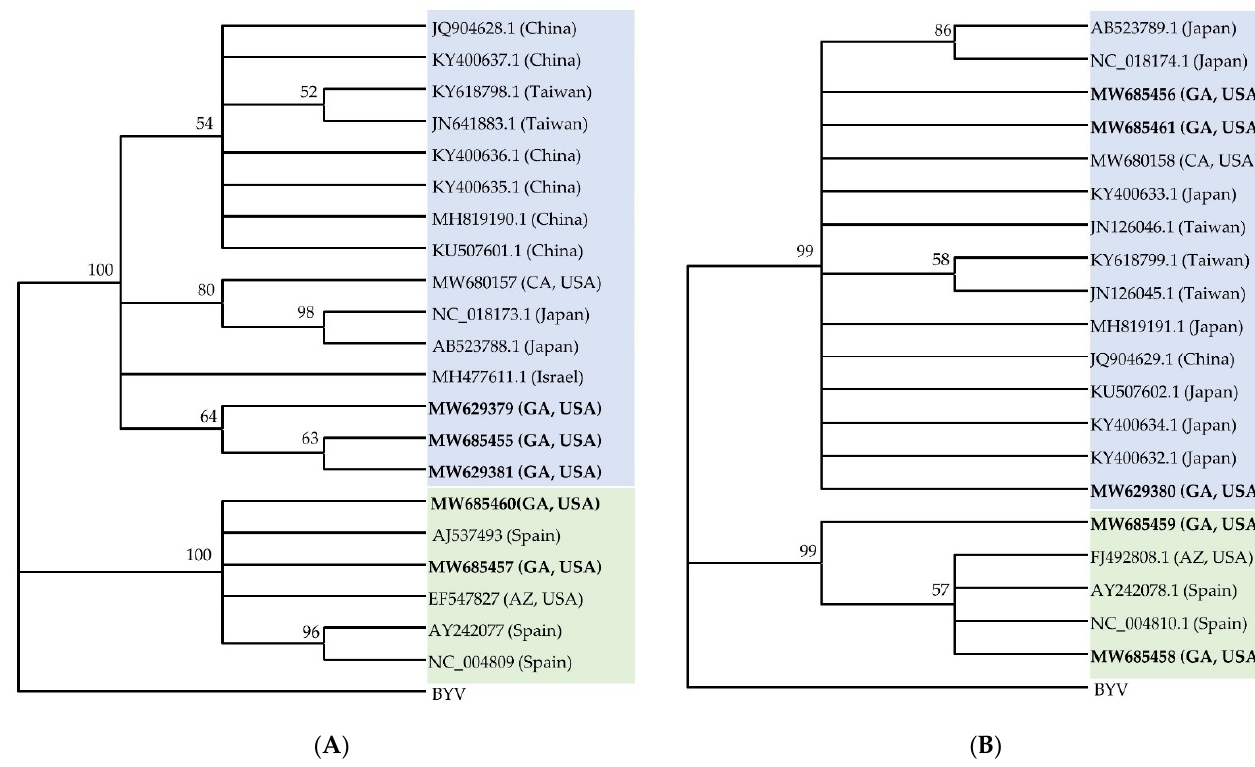
Figure 4. Phylogenetic relationship of coding regions of ( A ) RNA 1 and ( B ) RNA 2 of cucurbit chlorotic yellows virus (CCYV) and cucurbit yellow stunting disorder virus (CYSDV) isolates from Georgia with the corresponding sequences of CCYV and CYSDV isolates available in the GenBank. The country of origin of the sequences used are shown in parentheses after the accession numbers of viruses. CCYV sequences are shaded in blue and CYSDV sequences are in green. The Beet yellows virus (BYV) was set as an outgroup. Construction of the phylogenetic trees were done by the neighbor-joining method. The number on each node shows the percentage of bootstrap values (2000 replicates) in which a given node was recovered. Nodes with lower than 50 bootstrap values were collapsed since they were insignificant.